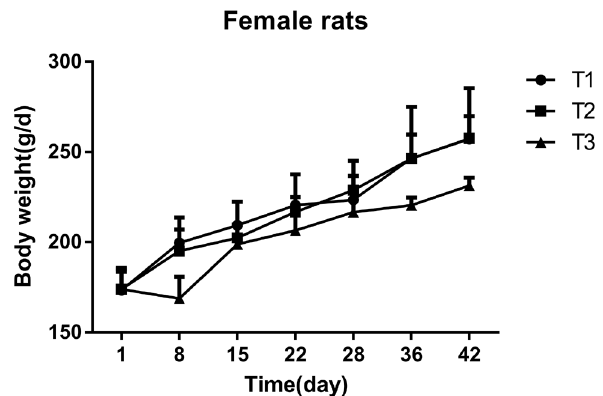
Figure 1. Effect of mulberry leaves on the body weight of Female rats. The x- and y-axes indicate time and body weight, respectively. T1 = control group; T2 = low dose group; T3 = high dose group. Error bars are standard error of the mean.